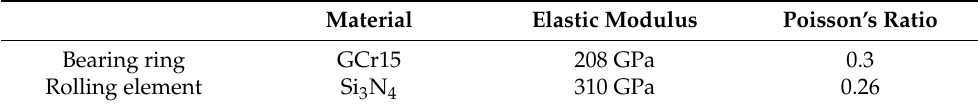
Table 2. Material parameters of bearing ring and rolling element.